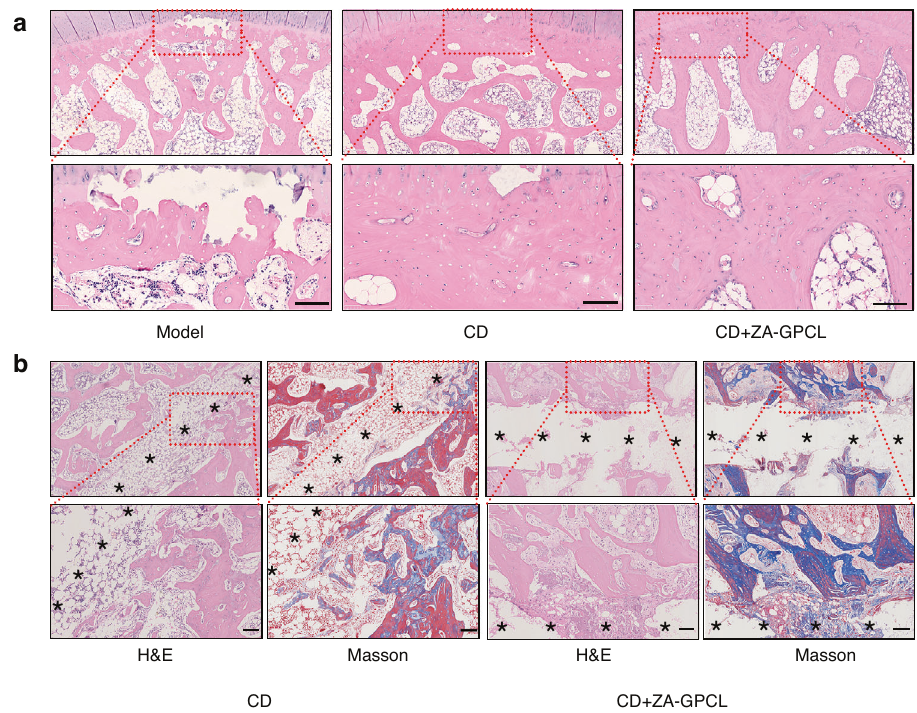
Fig. 6 Local therapeutic effect in vivo. a HE-stained subchondral bone. b HE- and Masson ’ s-stained bone regeneration in the core decompression tunnel. Black stars indicate CD tunnels. Undegraded GPCL was dissolved during the section staining process. Scale bars: 100 μ